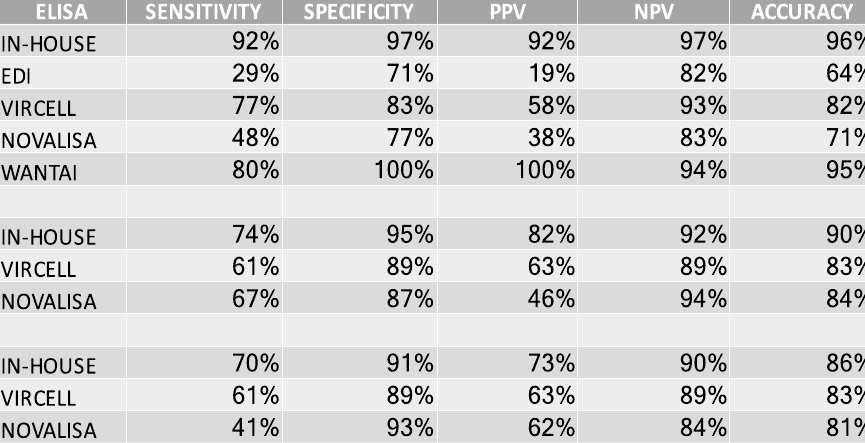
Figure 7. Tests characteristics of “in-house” ELISA and commercial ELISA kits. Three different antibody isotypes were evaluated.